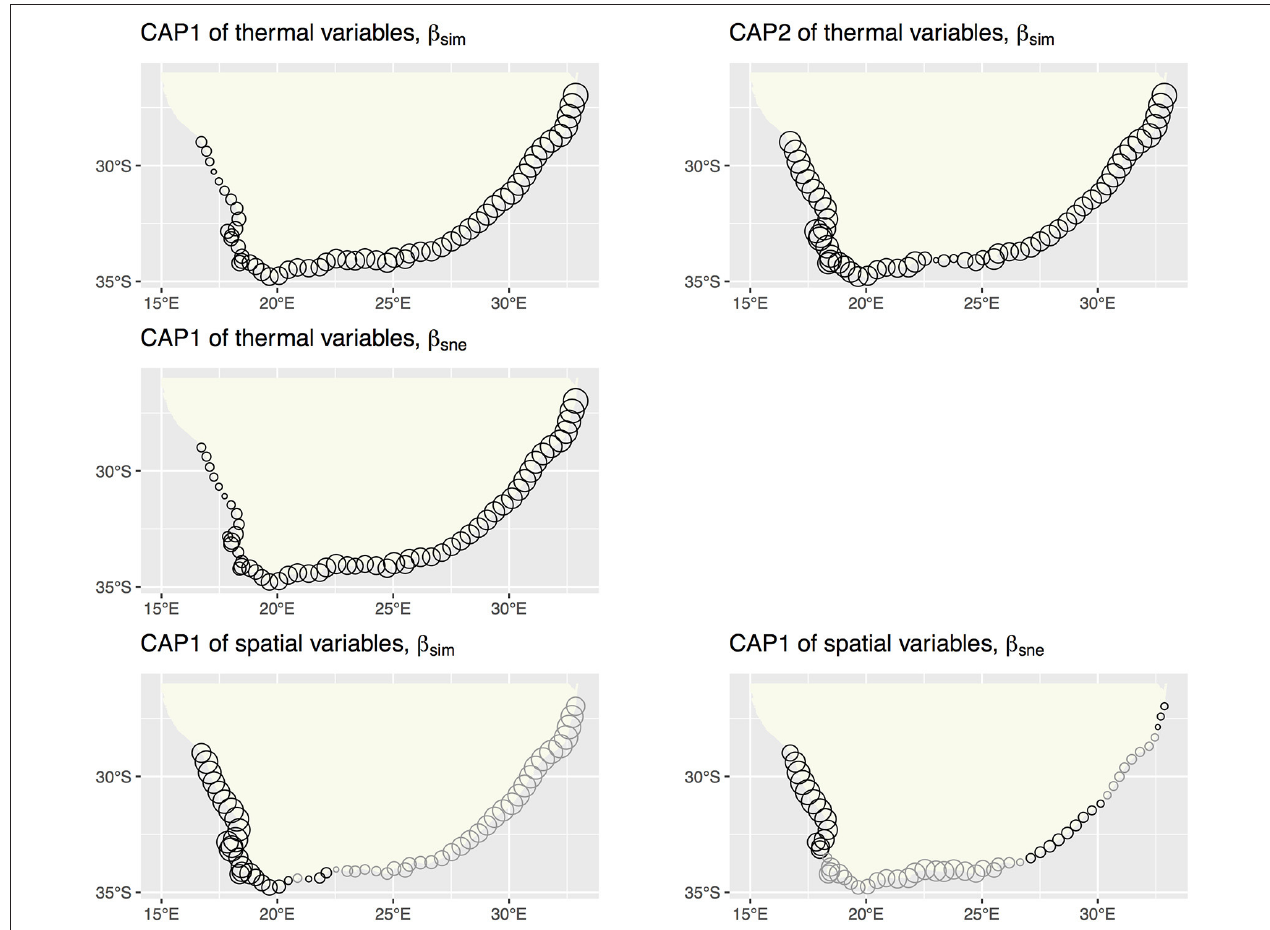
FIGURE 3 | db-RDA site scores for β sim and β sne on geographic coordinates. The site scores indicate the major gradients captured by the environmental and spatial (MEM) constraints. Gray circles indicate negative site scores.